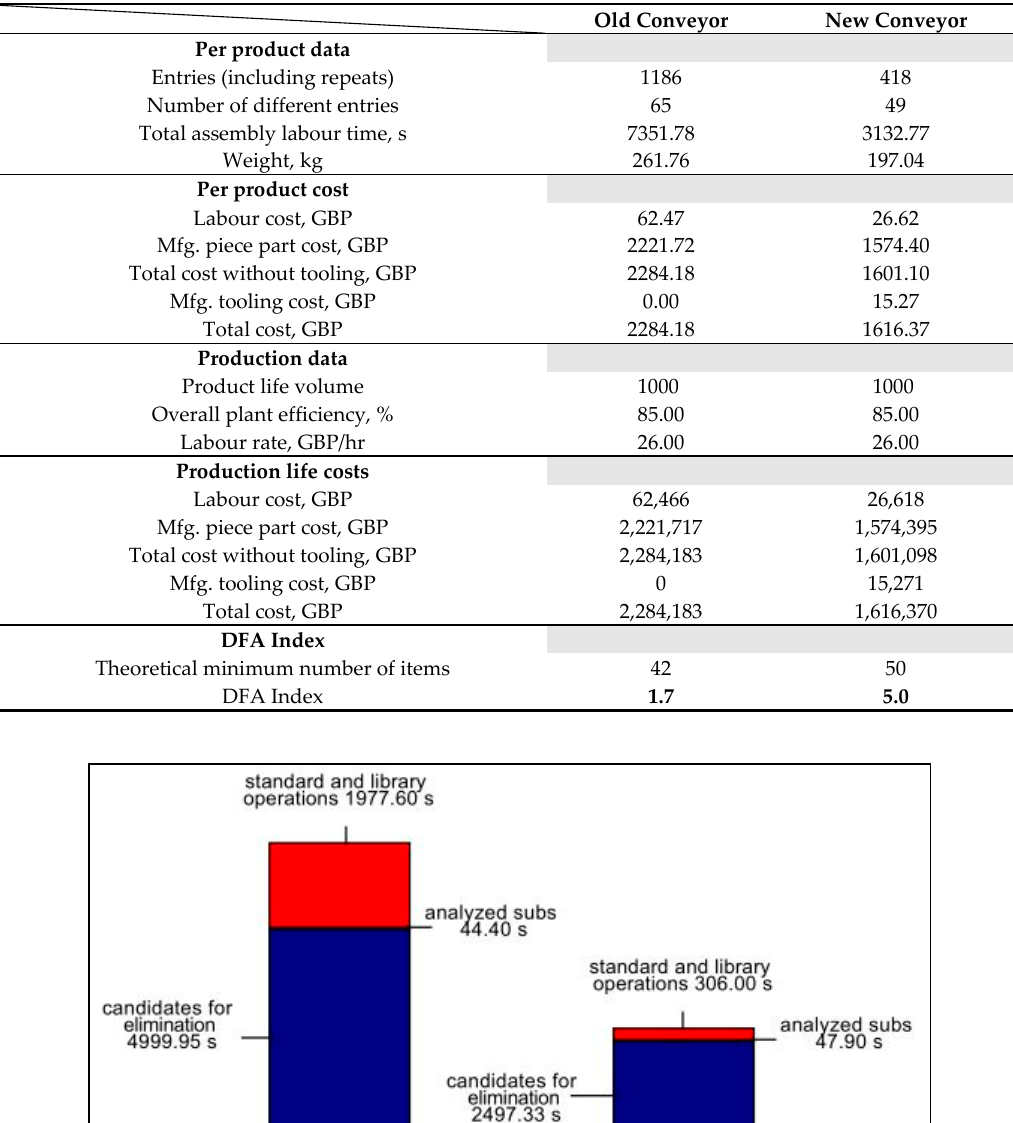
Table 8. Comparative analysis of old and new conveyor systems.